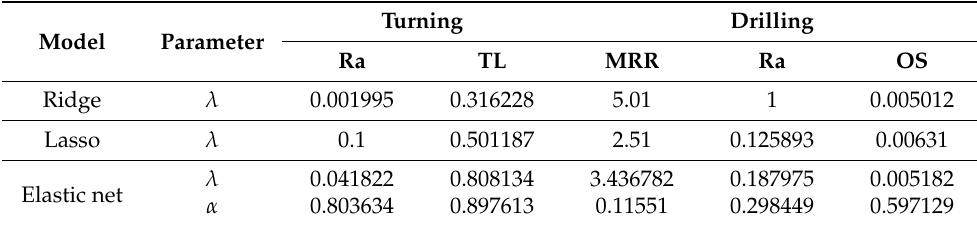
Table 1. Values of the corresponding tuning